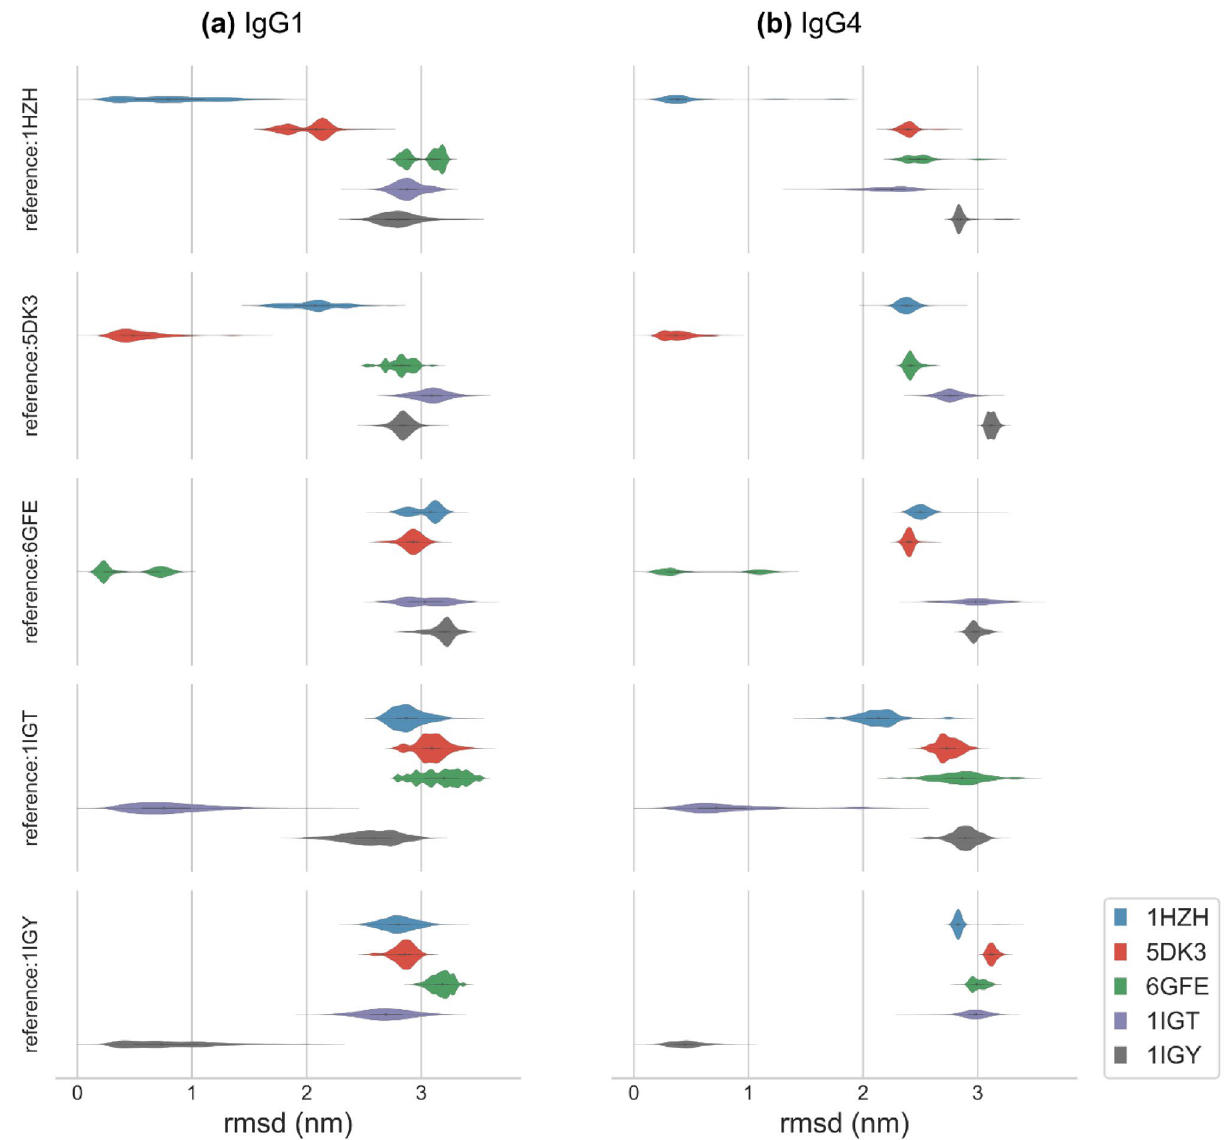
Figure 5. Violin plots showing the RMSD distributions for ( a ) IgG1 and ( b ) IgG4 trajectories spawned from the five full length antibody structures discussed in Fig. 3. A typical 500 ns trajectory in our studies contained 25,000 frames and every system contained two independent trajectories. Each frame in the trajectory was aligned to 25 conformations, each 20 ns apart, in a reference trajectory and RMSD was computed for each alignment. Thus, every distribution in the plot was computed from 1.25 million estimates. RMSD for cross alignment in which the trajectory structure differs from the reference is significantly higher than RMSD for self-alignment indicating that trajectories spawned from a crystal structure only samples conformational states around its initial